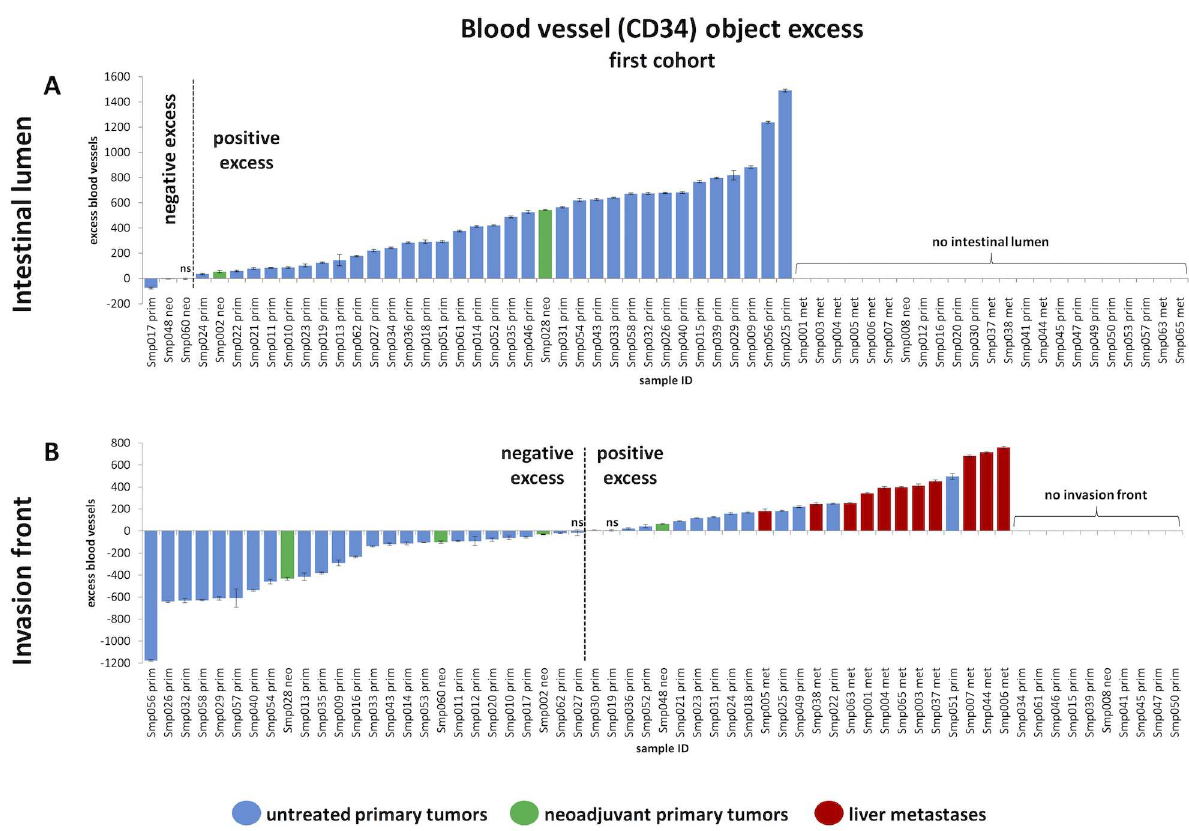
Fig 5. Magnitude of angiogenic zones for all analyzed samples in the first cohort, shown as waterfall plots. (A) Analysis of blood vessel aggregation in the tumor parts next to the intestinallumen. Statistically significantpositive blood vessel excess at the luminalside was detected in 33 of 34 untreated CRC primary tumors (“prim”, blue) and 2 of 4 neoadjuvantCRC primary tumors (“neo”, green). (B) Blood vessel excess at the invasionfront in N = 36 untreated CRC primary tumors (“prim”, blue), N = 4 neoadjuvantCRC primary tumors (“neo”, green), and N = 11 CRC liver metastases (“met”, red). (A-B) Error bars indicate the 95% confidenceinterval that was calculatedby a Monte Carlo method. All measurements are statistically significantexcept if labeled “ns” (for “not significant”).